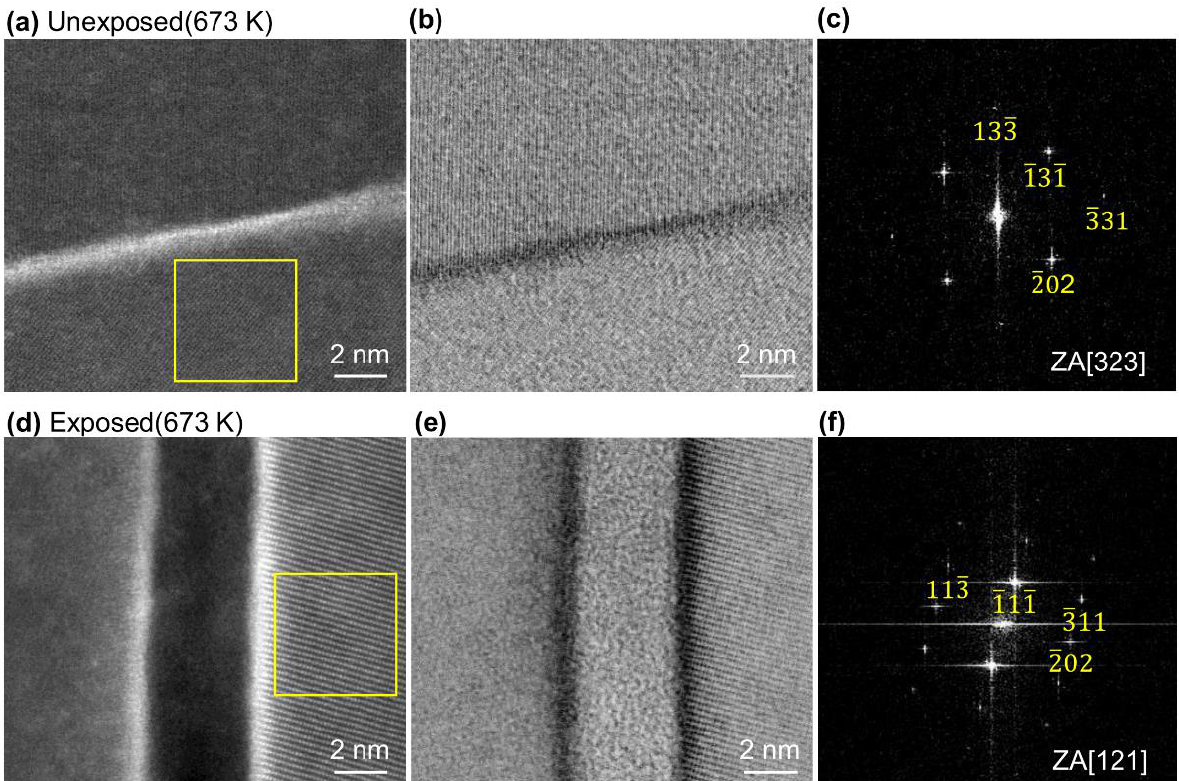
Figure 4. ( a ) HAADF-STEM image and ( b ) ABF-STEM image of unexposed Al compact sintered at 673 K under 600 MPa for 1 min, ( c ) fast Fourier transform (FFT) of the region indicated by yellow square in ( a ), ( d ) HAADF-STEM image and ( e ) ABF-STEM image of exposed Al compact sintered at 673 K under 600 MPa for 1 min showing the interface area between two Al grains, ( f ) FFT of the region indicated by yellow square in ( d ).